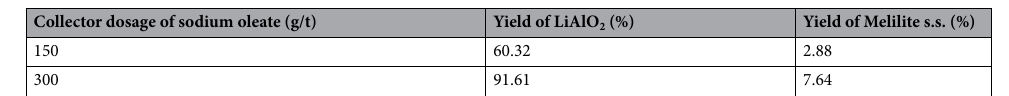
Table 2. Optimized Froth Flotation with a standard collector in a small flotation machine (Denver) and pine oil (150 g/t) as frother.